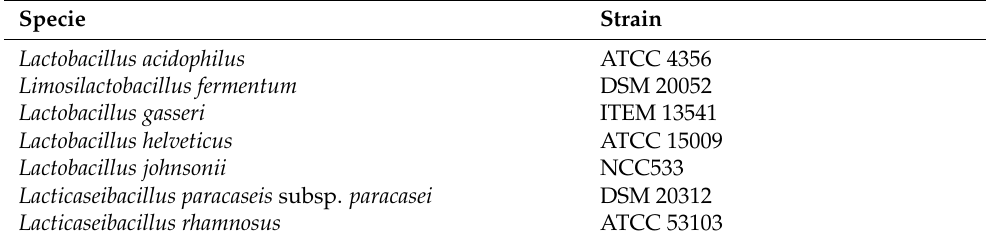
Table 1. Lactobacillus spp. strains used for the fermentation of legume-based water extracts [17]. Specie Strain